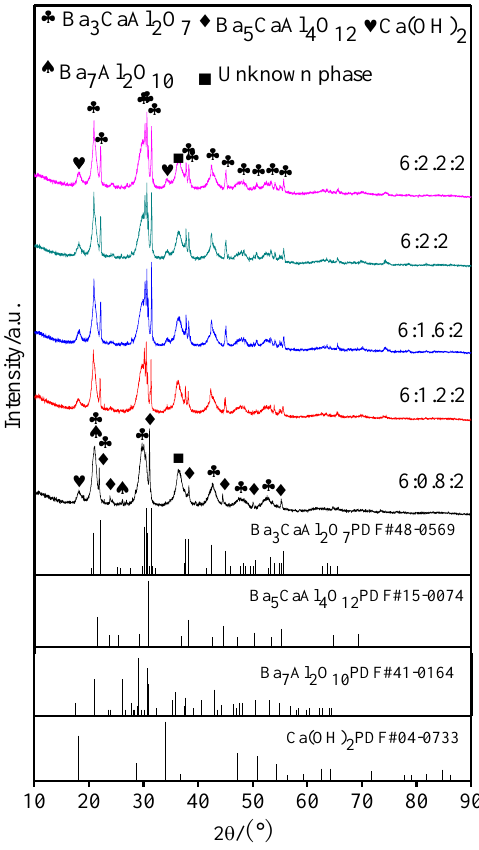
Figure 5. XRD patterns of 6BaO·xCaO·2Al 2 O 3 aluminates exposured to the air for 48 h.